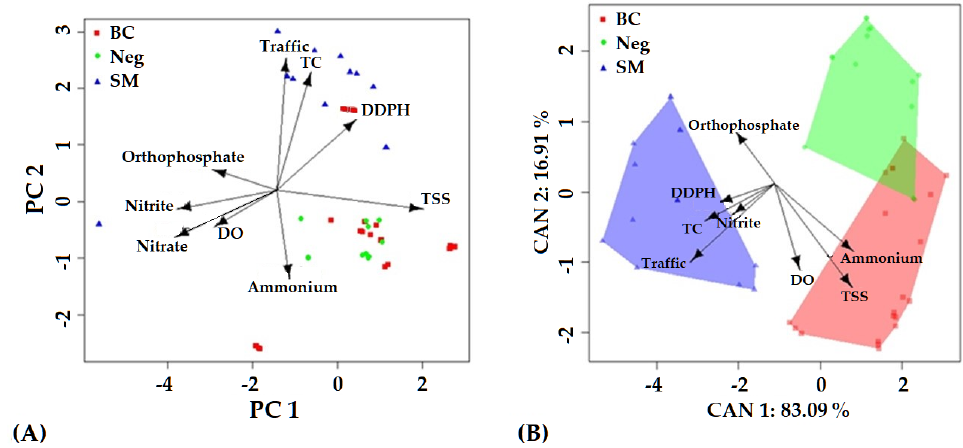
Figure 4. ( A ) Principal component analysis (PCA), and ( B ) representation of canonical variables showing the relevance of studied variables in discriminating sampling station. SM: International Marina of Santa Marta; BC: Concha Bay; Neg: Nenguange.